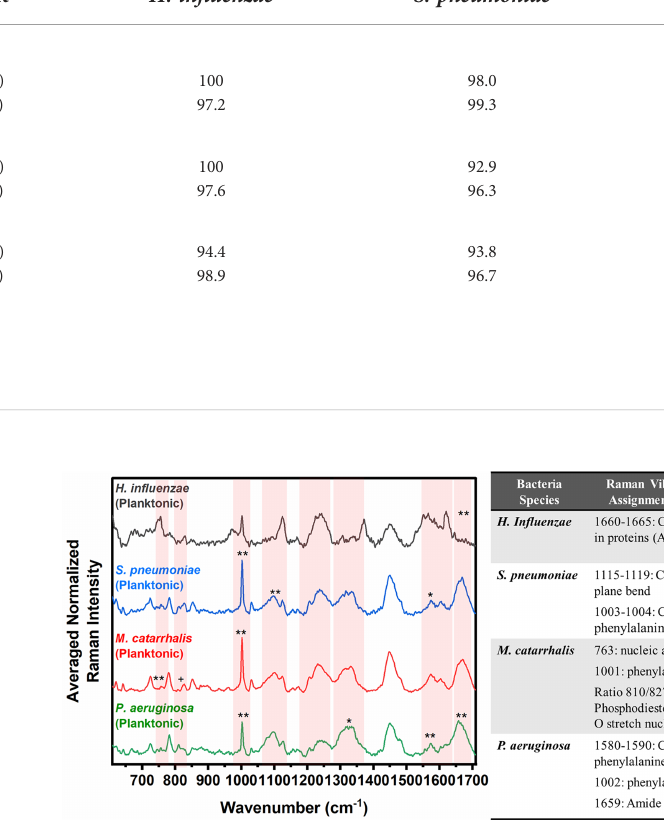
TABLE 2 A summary of the sensitivity and speci fi city using SMLR to differentiate the four bacterial species for a given environment using RS. Environment